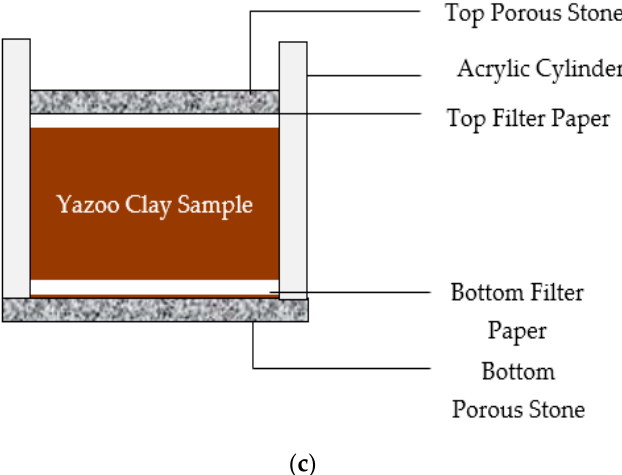
Figure 2. ( a ) Samples undergoing the wetting cycle; ( b ) samples undergoing the drying cycle inside the wet-dry cycle chamber; ( c ) schematics of the wet-dry cycle sample mold.